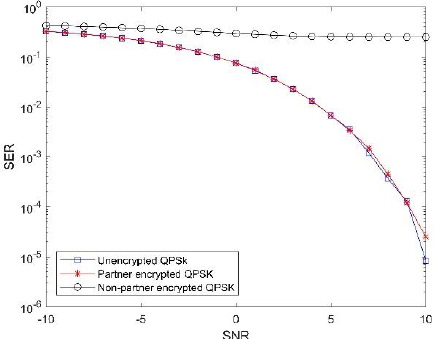
Figure 9. Constellation diagram of 16QAM modulation of SNR = 15 dB, in which ( a ) is the unen- crypted constellation diagram and ( b ) is the encrypted constellation diagram.